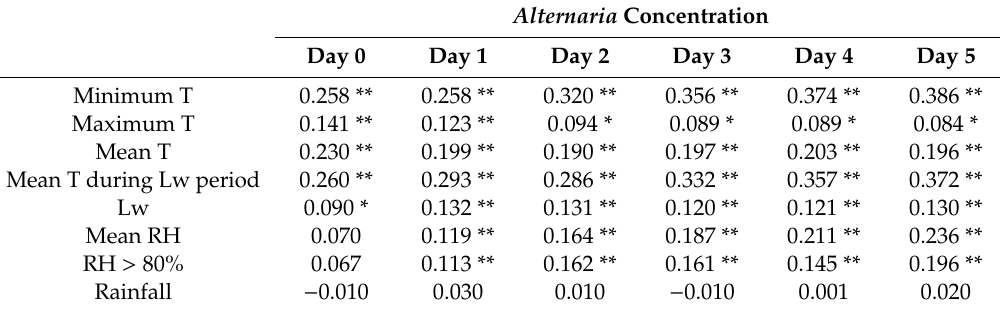
Table 6. Spearman correlation coe ffi cients between Alternaria concentration and meteorological variables since 5 days before.